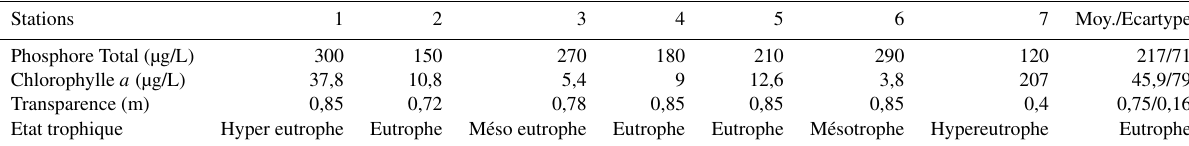
Tableau B4. Niveau trophique (MDDEP, 2004) de la retenue d’eau au mois de septembre. Stations